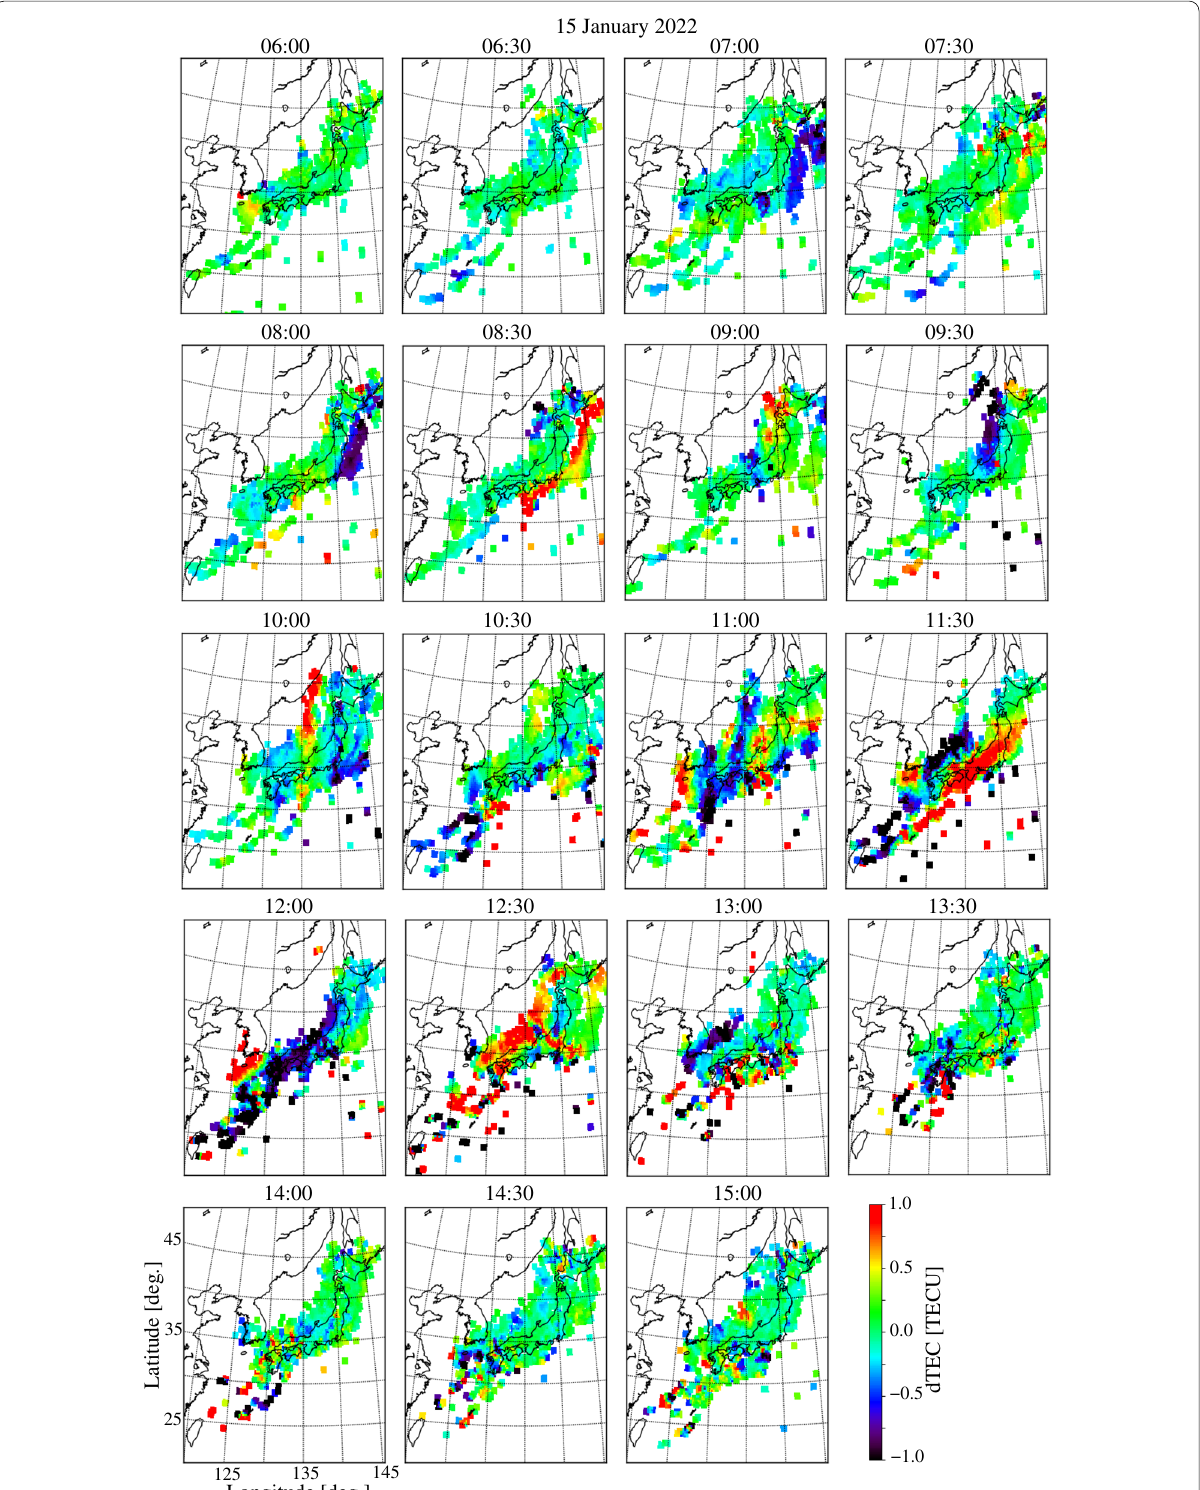
Fig. 2 TEC perturbation maps from 0600 to 1500 UT (1500 to 2400 JST) on 15 January